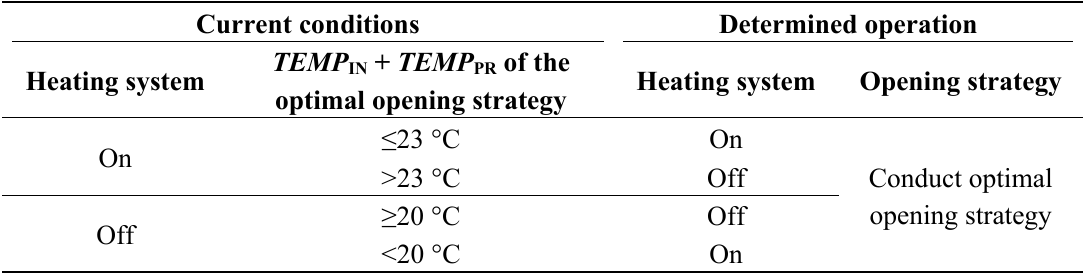
Table 3. Control algorithm of ANN-based temperature control logic.